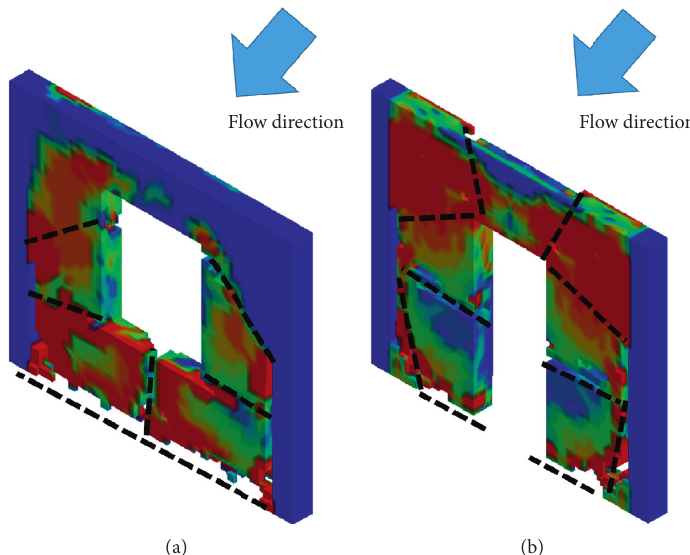
Figure 10: Snapshots of the maximum principal strain at the moment of failure in the scenario of s � 1, h � 1.6 m, and v � 8.0m/s for (a) the frontal masonry wall with a window, and (b) the frontal masonry wall with a door (black dashed lines representing fracture lines, maximum principal strains increasing from blue to red